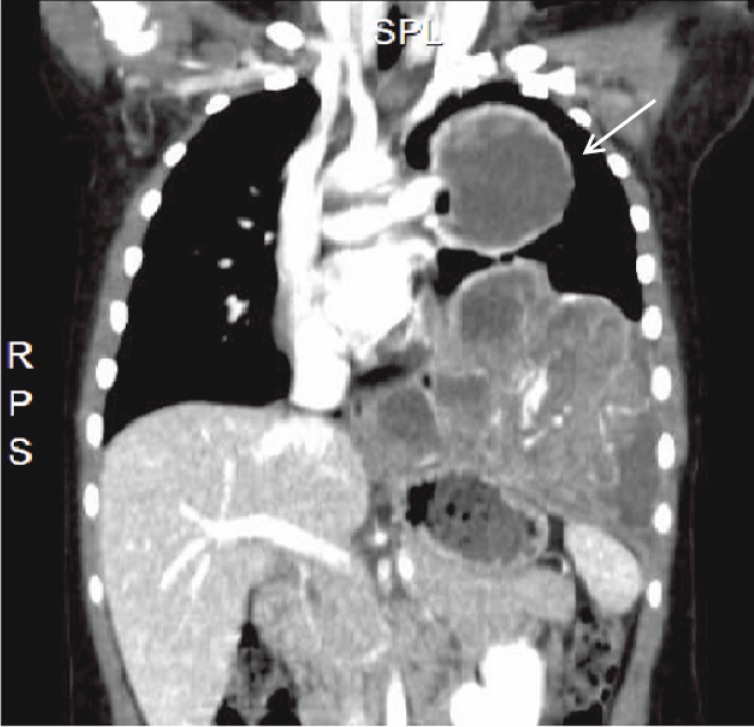
CT scan: coronal reconstruction of a left lung mass (arrow)